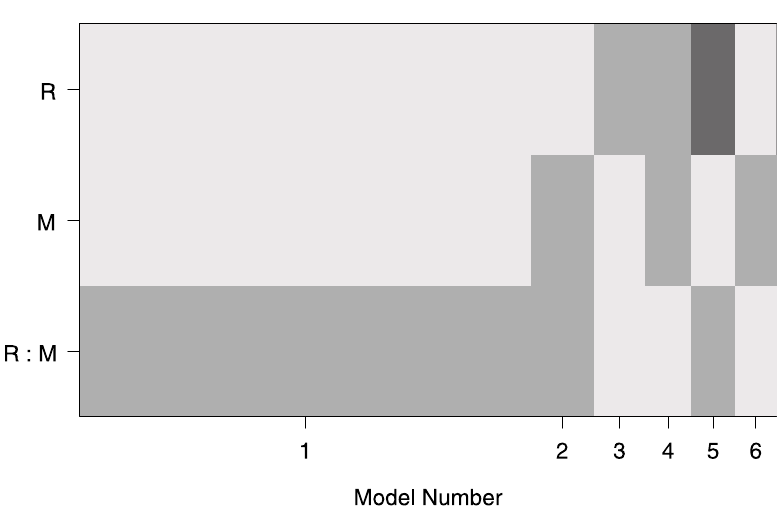
Fig 5. A graph of the selected models explaining the use ofindirect methods of abuse using Bayesian Model Averaging analysis. Width of individual rectangles reflects the posterior probability of each model being correct.